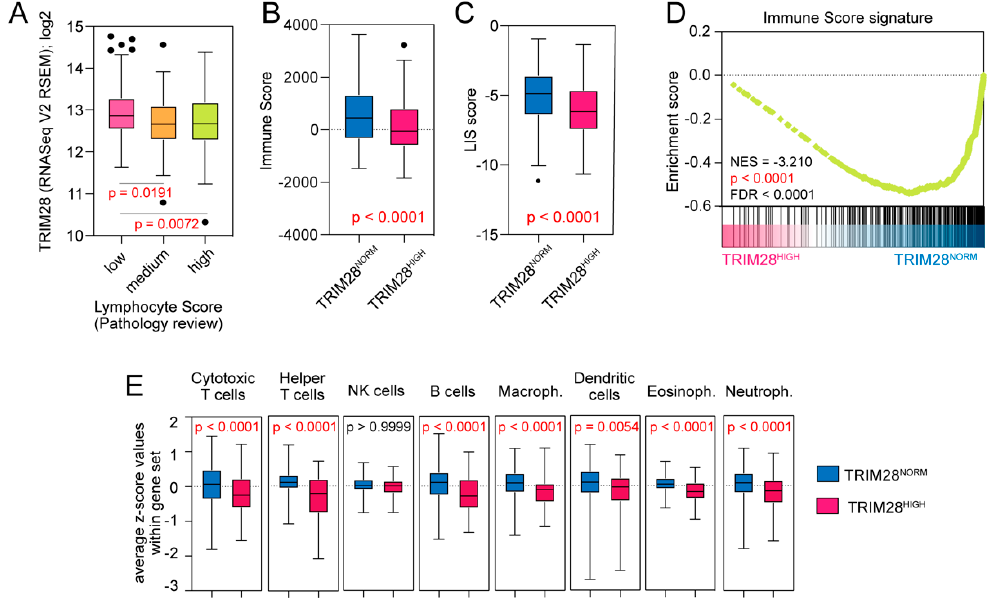
Figure 4. TRIM28 high expressing melanomas are significantly depleted with tumor infiltrating lymphocytes. ( A ) Tukey box plots of the expression of TRIM28 in melanomas with low (0 and 2), medium (3 and 4), or high (5 and 6) lymphocyte score as determined with a pathology review [30] in the SKCM TCGA data. The statistical significance is denoted in the graph (ANOVA followed by Tukey’s multiple comparisons test). ( B ) Tukey box plots of the Immune Score (ESTIMATE [31]) in TRIM28 NORM and TRIM28 HIGH melanomas. ( C ) Tukey box plots of the Leukocyte Infiltration Score (LIS [32]) in TRIM28 NORM and TRIM28 HIGH melanomas. ( D ) The GSEA with all DEGs in TRIM28 HIGH vs. TRIM28 NORM ( n = 9165) revealed significant depletion of the Immune Score signature (only genes positively associated with the Immune Score signature were used as a reference). ( E ) Tukey box plots of the average z-score values for genes within genesets corresponding to transcriptome profiles of specific leukocyte subpopulations [33]. The average z-scores were calculated using R2: Genomics Analysis and Visualization Platform.